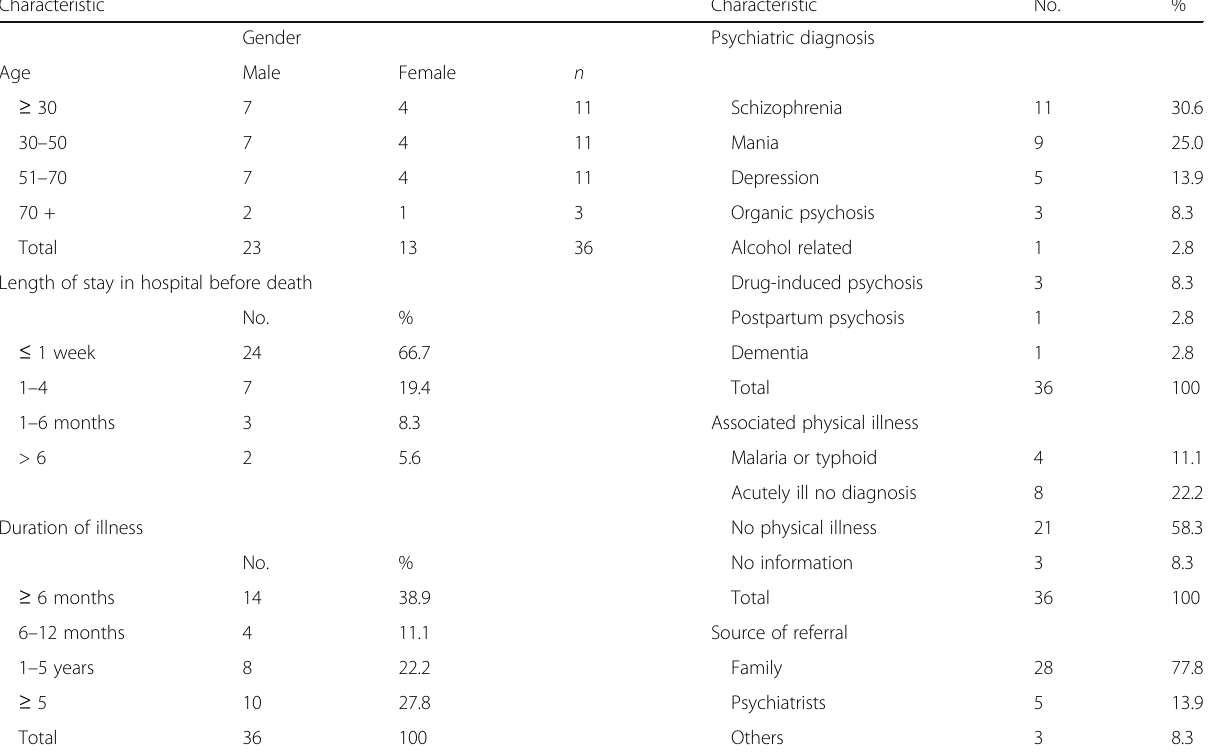
Table 1 Mortality characteristics Characteristic